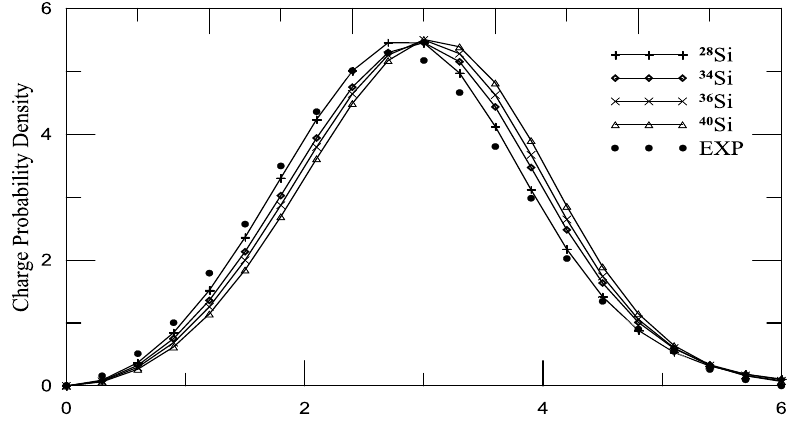
Fig. 6: Comparison of the experimental and theoretical charge probability density distributions for 28,32,36,40 Si, by using the